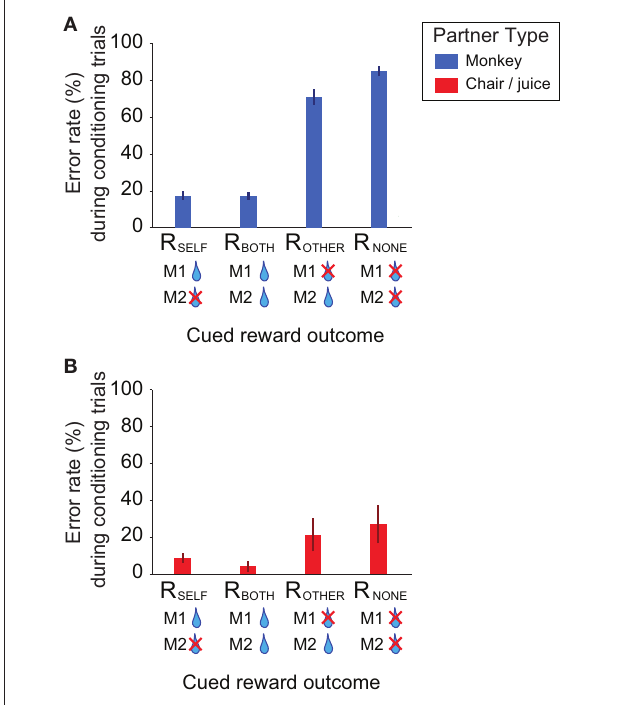
Figure 2 | error patterns during instrumental conditioning demonstrate rhesus macaques are sensitive to other’s rewards. (A) Error rates (excluding first sessions) on the instrumental conditioning trials (mean of sessions ± SEM) in M1–M2 conditions ( n = 57 sessions). (B) Error rates in the non-social (M1–C/J) controls ( n = 9 sessions). Same format as in (A)